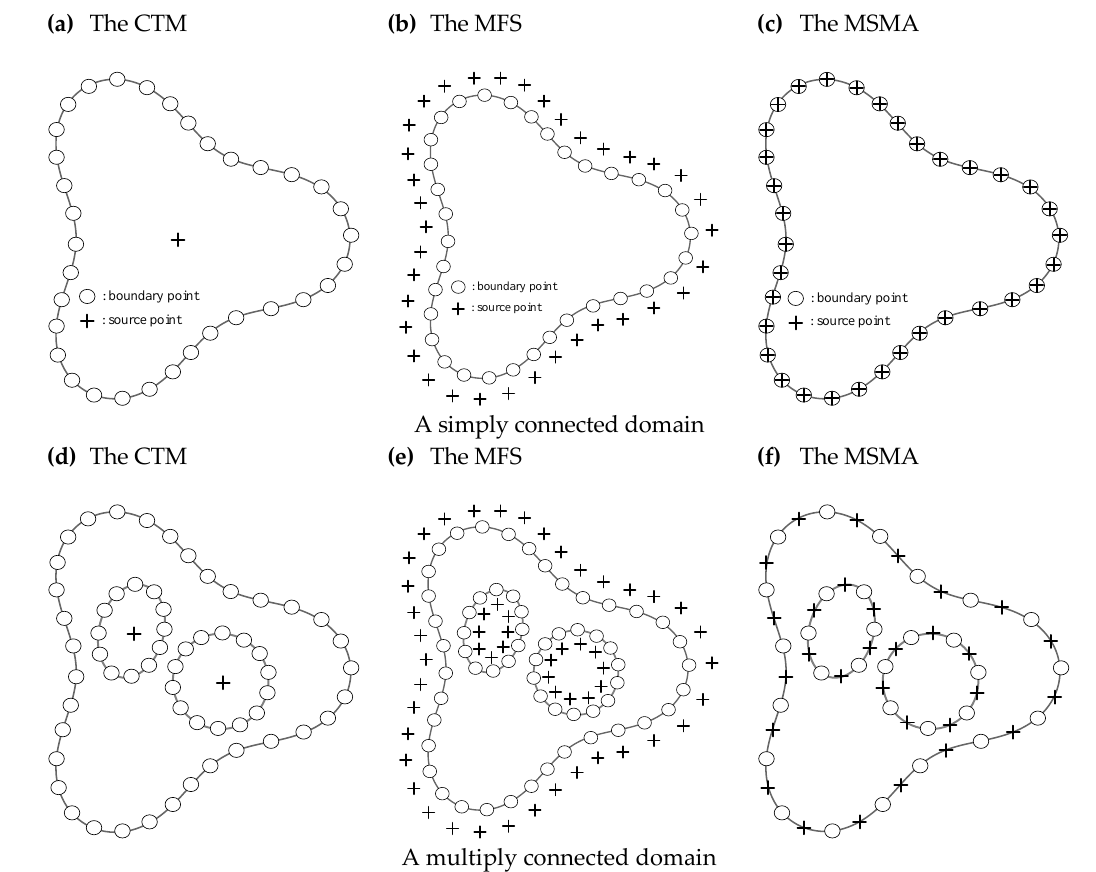
Figure 1. Illustration of the collocation points for the collocation Trefftz method (CTM), method of fundamental solutions (MFS), and multiple source meshfree approach (MSMA).